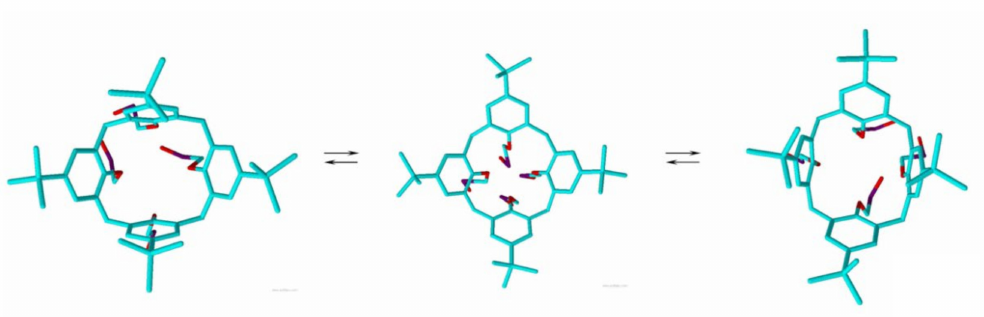
Figure 4. Pinched cone ↔ pinched cone interconversion of the Co(II) calix[4]arene complex (the Co cation and butyl chains of phosphineoxide are removed for clarity).